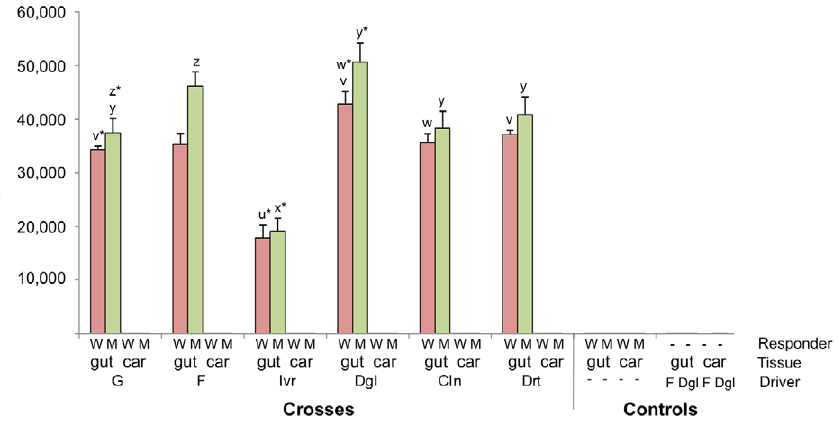
Figure 3. Luciferase activity in midguts and carcasses of female mosquitoes. Mean luciferase activity from dissected midguts and remaining carcass is shown for progeny heterozygous for Gal4 and UAS cassettes (RLU=Relative Light Units, N=6). All samples are from sugarfed mosquitoes. Controls for both responder lines are homozygous for UAS cassette (N=3), and the control driver lines F and Dgl are homozygous for Gal4 cassette (N=6). The responder line (W=Wnd, M=Mbl), the tissue examined (gut=midgut, car=carcass) and the driver line utilized in each cross and in the controls, are indicated along the X-axis. Error bars show standard errors. Significance differences (Mann Whitney, p , 0.05) in midgut specific expression between crosses involving different driver lines but the same responder line are indicated by letters above each bar. u* and x* indicates significant difference between progeny from these crosses compared to all others. Other letters marked * (ie v*, w*, y*, z*) indicate significant difference only to those crosses bearing the same letter (ie v* is significantly different to